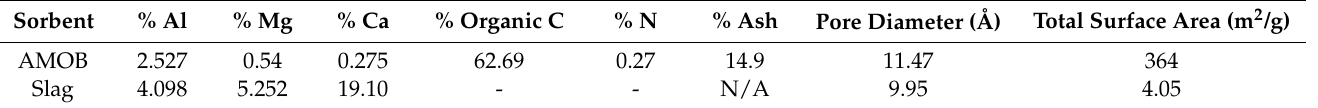
Table 1. Elemental analysis and surface area